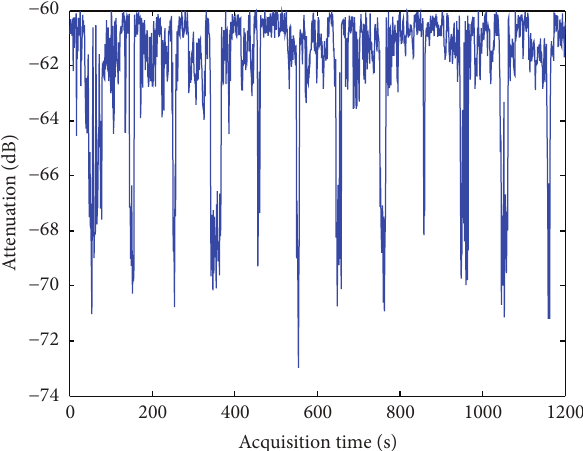
Figure 11: Measured attenuation of power arch supply.